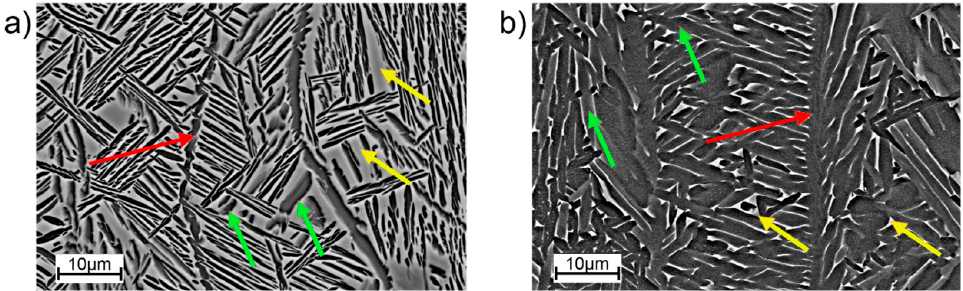
Figure 7. Microstructure of PBF-EB/Ti-55511: ( a ) as-built, ( b ) HIP. SEM. Arrows: red—borders of the column ( α GB), yellow— β phase lamellae, green— α phase lamellae.